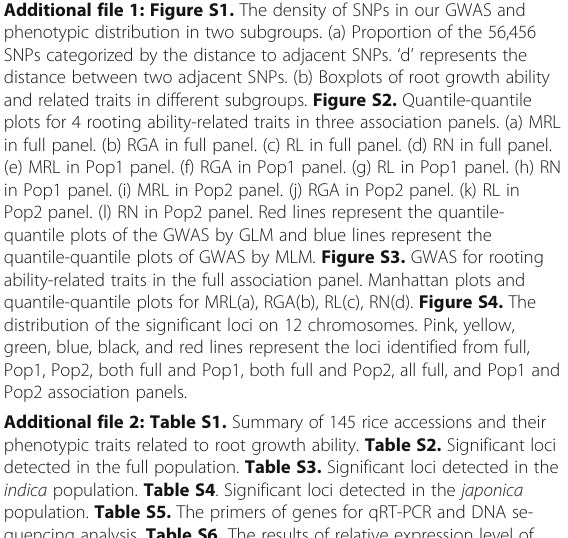
Additional file 1: Figure S1. The density of SNPs in our GWAS and phenotypic distribution in two subgroups. (a) Proportion of the 56,456 SNPs categorized by the distance to adjacent SNPs. ‘ d ’ represents the distance between two adjacent SNPs. (b) Boxplots of root growth ability and related traits in different subgroups. Figure S2. Quantile-quantile plots for 4 rooting ability-related traits in three association panels. (a) MRL in full panel. (b) RGA in full panel. (c) RL in full panel. (d) RN in full panel. (e) MRL in Pop1 panel. (f) RGA in Pop1 panel. (g) RL in Pop1 panel. (h) RN in Pop1 panel. (i) MRL in Pop2 panel. (j) RGA in Pop2 panel. (k) RL in Pop2 panel. (l) RN in Pop2 panel. Red lines represent the quantile- quantile plots of the GWAS by GLM and blue lines represent the quantile-quantile plots of GWAS by MLM. Figure S3. GWAS for rooting ability-related traits in the full association panel. Manhattan plots and quantile-quantile plots for MRL(a), RGA(b), RL(c), RN(d). Figure S4. The distribution of the significant loci on 12 chromosomes. Pink, yellow, green, blue, black, and red lines represent the loci identified from full, Pop1, Pop2, both full and Pop1, both full and Pop2, all full, and Pop1 and Pop2 association panels. Additional file 2: Table S1. Summary of 145 rice accessions and their phenotypic traits related to root growth ability. Table S2. Significant loci detected in the full population. Table S3. Significant loci detected in the indica population. Table S4 . Significant loci detected in the japonica population. Table S5. The primers of genes for qRT-PCR and DNA se- quencing analysis. Table S6. The results of relative expression level of candidate